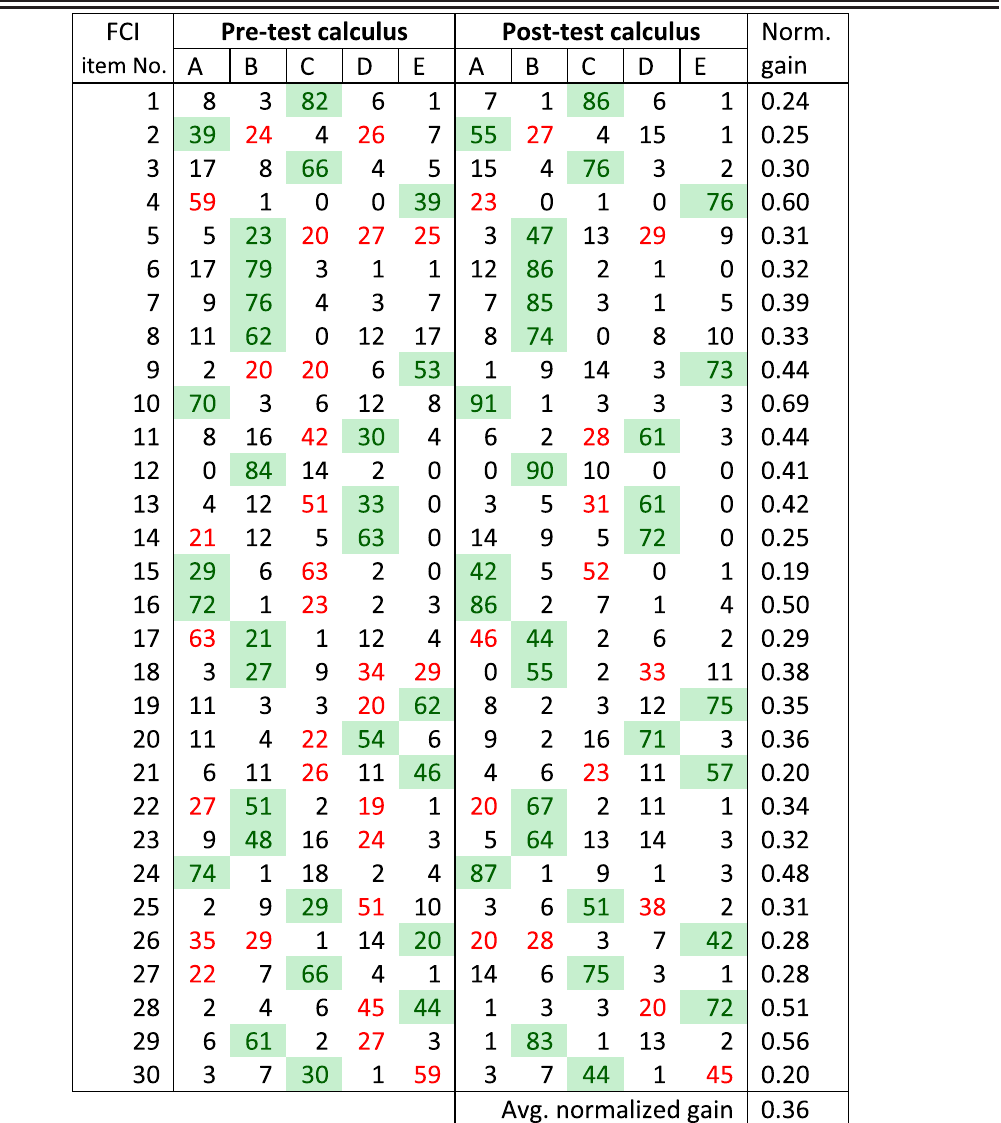
TABLE IX Percentages of calculus-based introductory physics students who selected each answer choice for each item on the FCI when it was given as a pretest and as a post-test. The percentages on the pretest are based on data from 364 students taught by three different instructors over several semesters and the percentages on the post-test are based on data from 296 students taught by two different instructors during two different semesters. The green shaded boxes indicate correct answers and red font indicates incorrect answer choices selected by 20% or more students. All the courses were taught in a traditional manner which did not incorporate PER based teaching